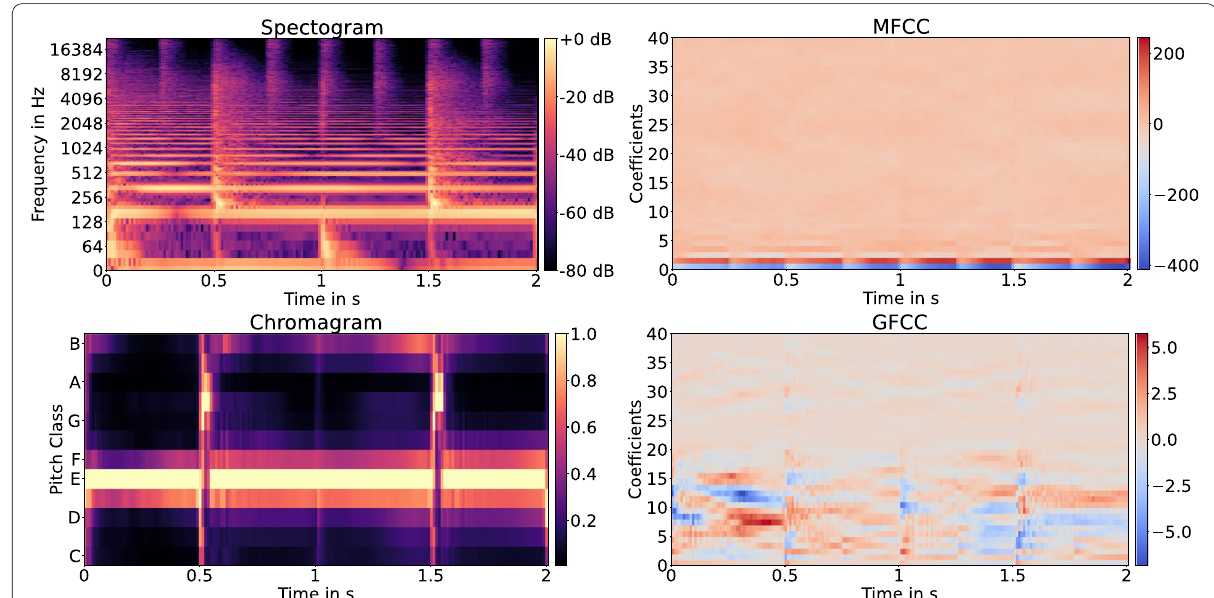
Fig. 3 Example of all four investigated time-frequency representations of one sample of the GEPE-GIM dataset with distortion on the guitar and gain set to 0.7 and tone set to 0.85 at a mixing volume of